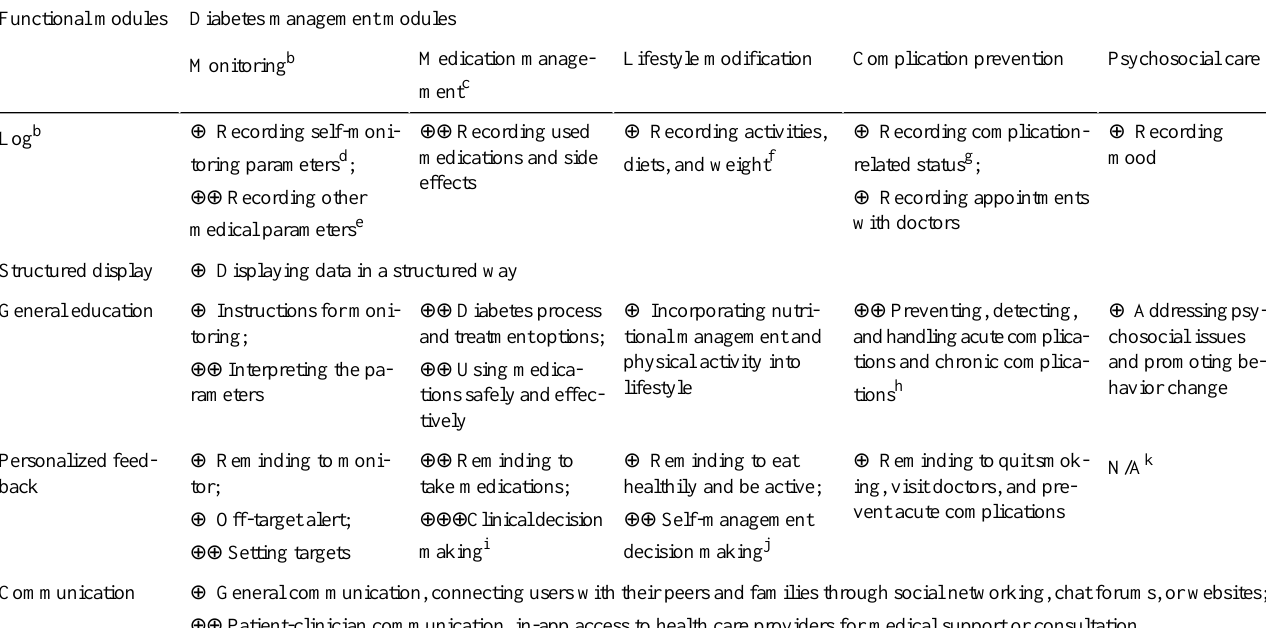
Table 1. Taxonomy of apps for diabetes